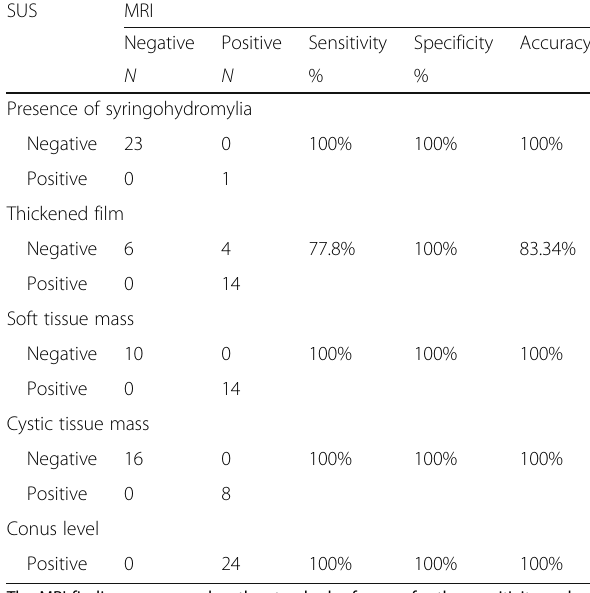
Table 2 Comparison between ultrasonographic and MRI imaging in the diagnosis of spinal dysraphism